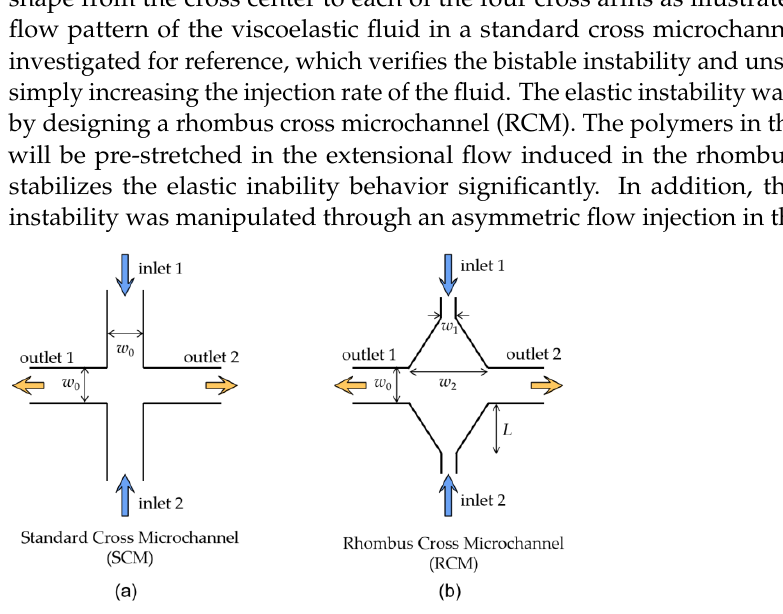
Figure 1. Schematic of ( a ) standard cross microchannel (SCM) and ( b ) rhombus cross microchannel